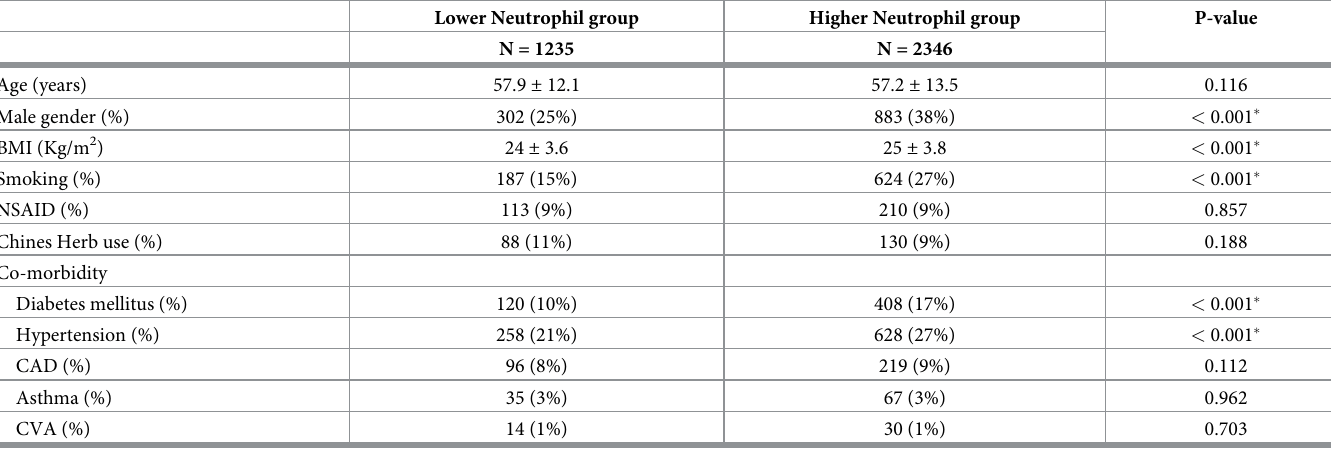
Table 7. Demographic data of study population with lower and higher peripheral neutrophil counts.